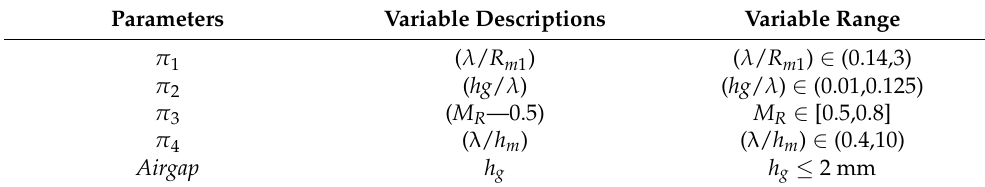
Table 2. Model Calibration Ranges.